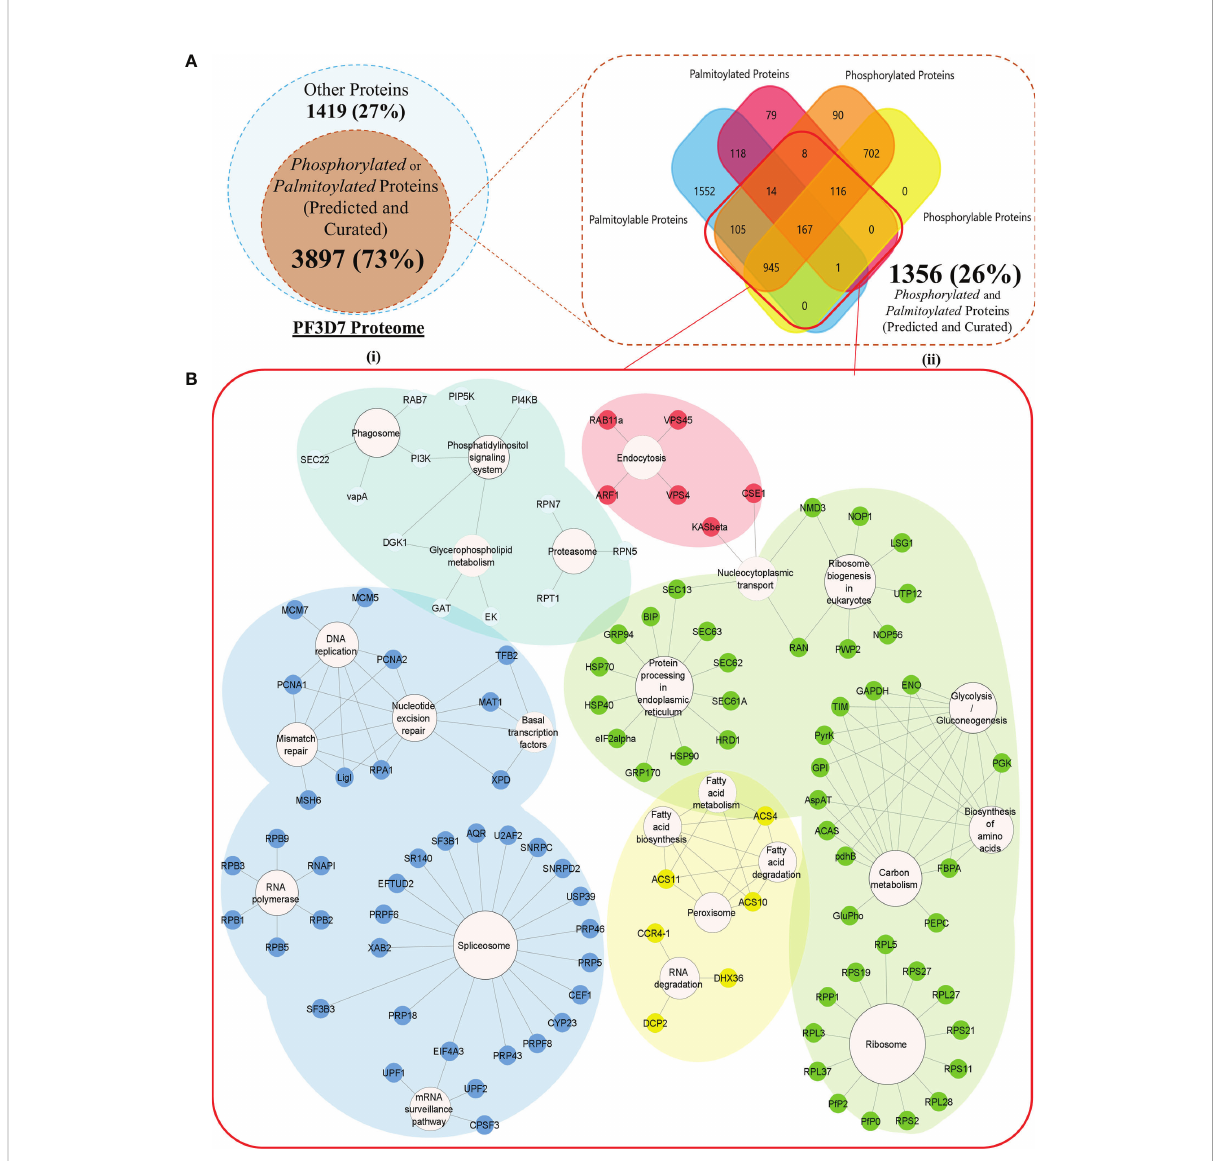
FIGURE 2 (A) (I) A Venn diagram representing all the Modi fi able proteins (inner subset; dark orange) in the proteome of Plasmodium falciparum 3D7 (outer subset; light blue). (II) A Venn diagram with a more detailed breakdown of the proteins processed or predicted to be processed by palmitoylation and phosphorylation (the red box encapsulates all the dually modi fi able proteins) (B) Biological processes enriched by proteins grouped into each of the fi ve k-means clusters of the dually modi fi able proteins. (Cluster 1 represented by Red, cluster 2 represented by Yellow, cluster 3 represented by Green, cluster 4 represented by Cyan, and cluster 5 represented by Blue